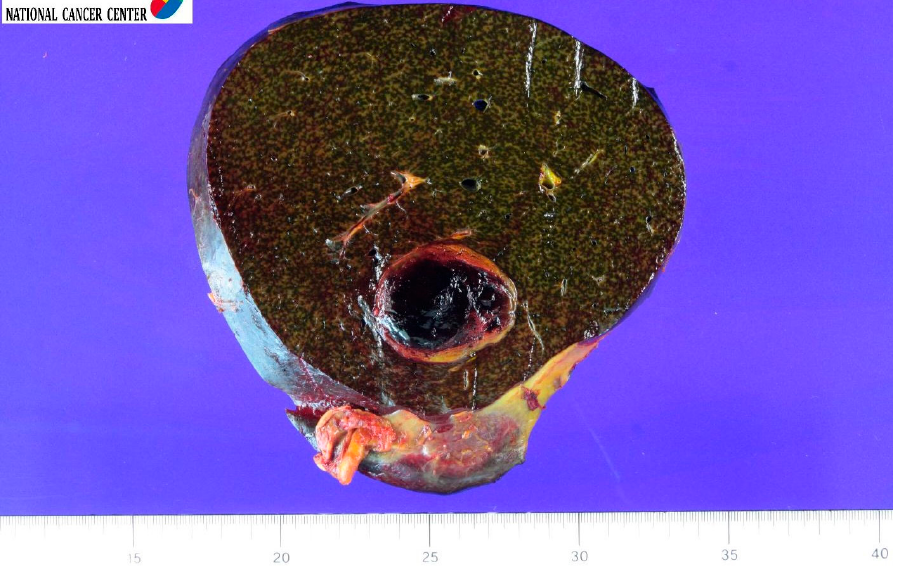
Figure 5. Gross specimen of the explanted right liver allograft demonstrating a green cholestatic cut surface with an intraparenchymal organizing hematoma measuring 4 cm in size at the time of re- transplantation.